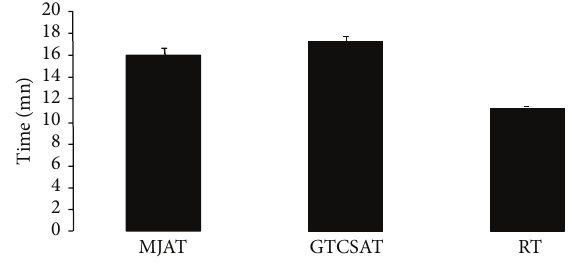
Figure 2: Myoclonic jerks appearance time (MJAT), generalised tonic-clonic seizure appearance time (GTCSAT), and recovery time (RT) after a first exposure ( 𝑛 = 15 for each group). Data are shown as mean values ± SEM.